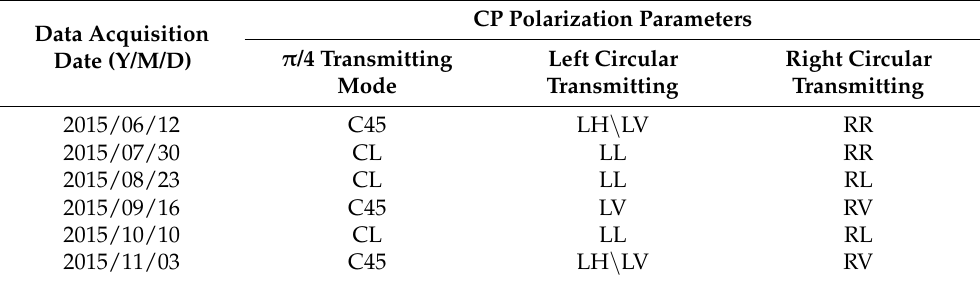
Table 2. The optimal CP parameters for distinguishing T–H and